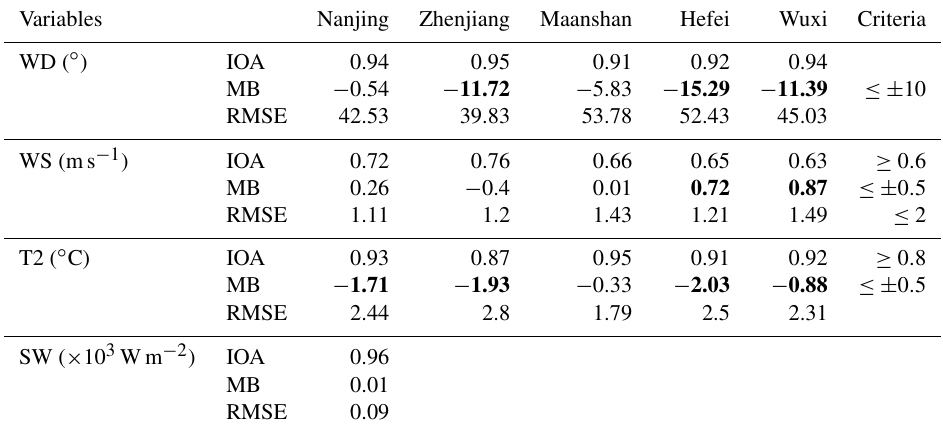
Table 2. Statistical metrics for meteorological variables from 10 to 26 October 2015. The benchmarks follow the recommended values reported by Emery et al. (2001). The values that do not meet the criteria are denoted in bold. Variables